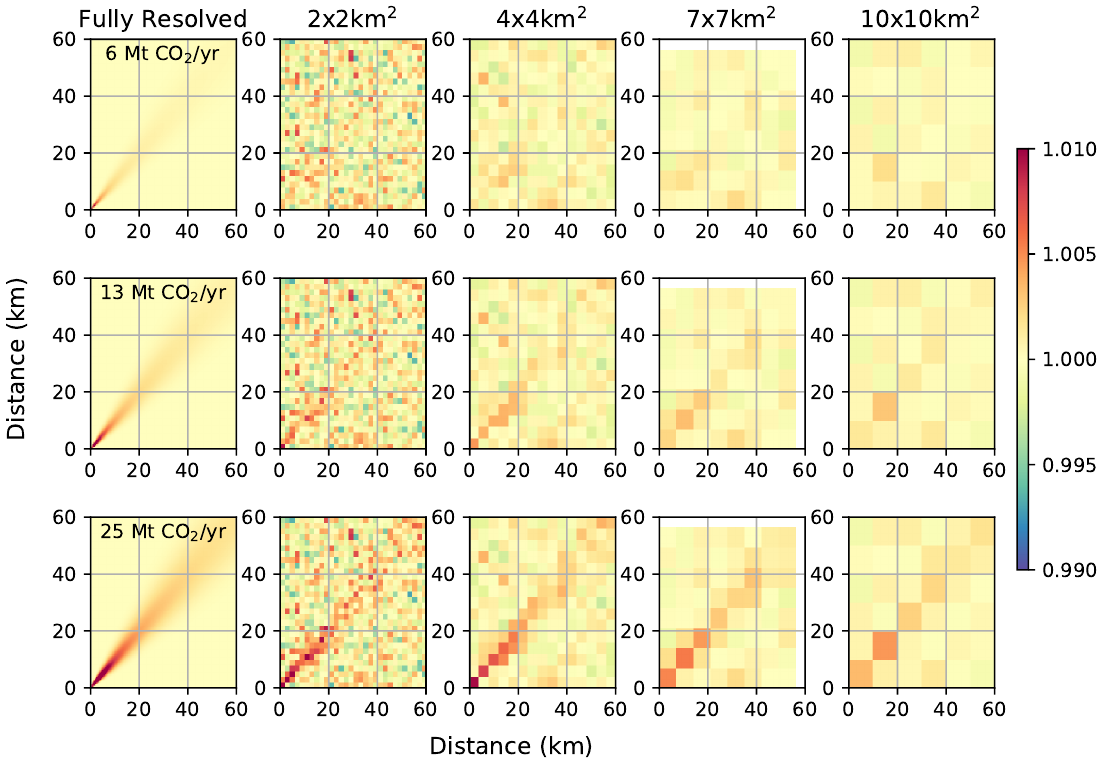
Figure 1. Model and simulated column-averaged CO 2 mole fraction (XCO 2 ) observations relative to a constant 400 ppm background for 3 source emission rates and 4 pixel sizes. The first column shows the simulated Gaussian plume at 50 m resolution for each power plant emission rate against a clean background. Columns 2, 3, 4, and 5 show the simulated observations averaged to pixels of size 2 × 2 km 2 , 4 × 4 km 2 , 7 × 7 km 2 , and 10 × 10 km 2 , respectively. The top row shows the simulated observations for a source with emission rate 6 Mt yr − 1 , the middle row shows observations for a 13 Mt yr − 1 source, and the bottom row shows observations for a 25 Mt yr − 1